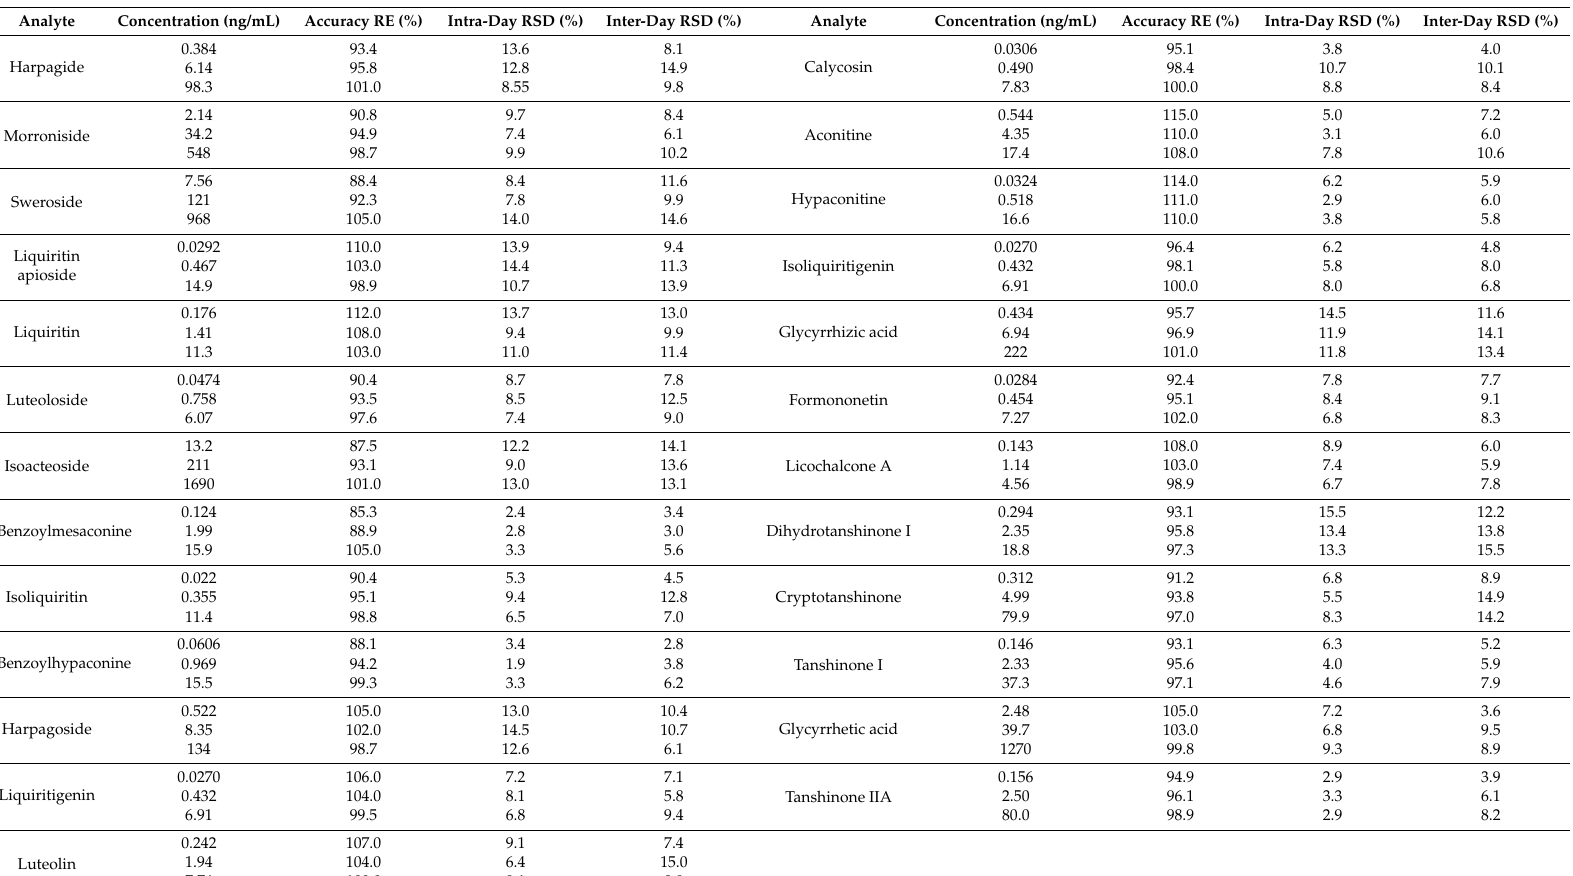
Table 3. Precision and accuracy data for the twenty-five ananlytes ( n = 6).